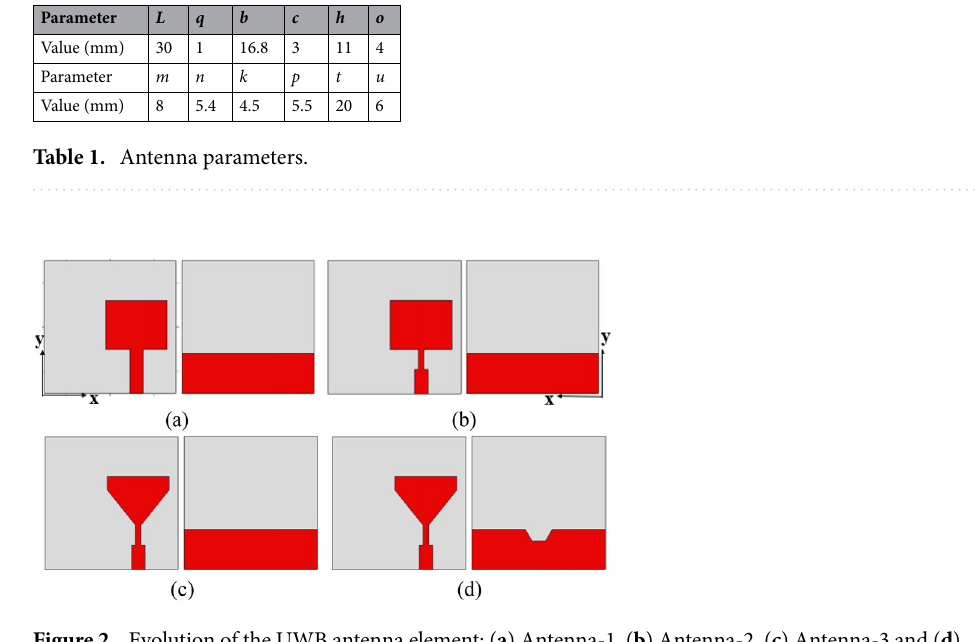
Figure 2. Evolution of the UWB antenna element: ( a ) Antenna-1, ( b ) Antenna-2, ( c ) Antenna-3 and ( d )